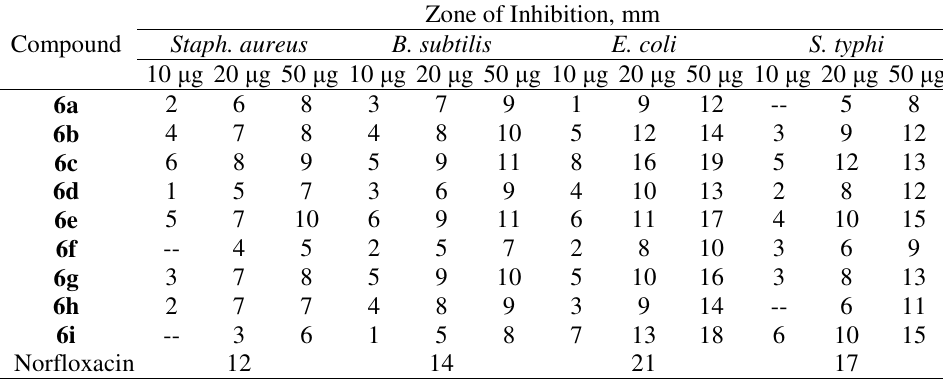
Table 2. Antibacterial activity data of